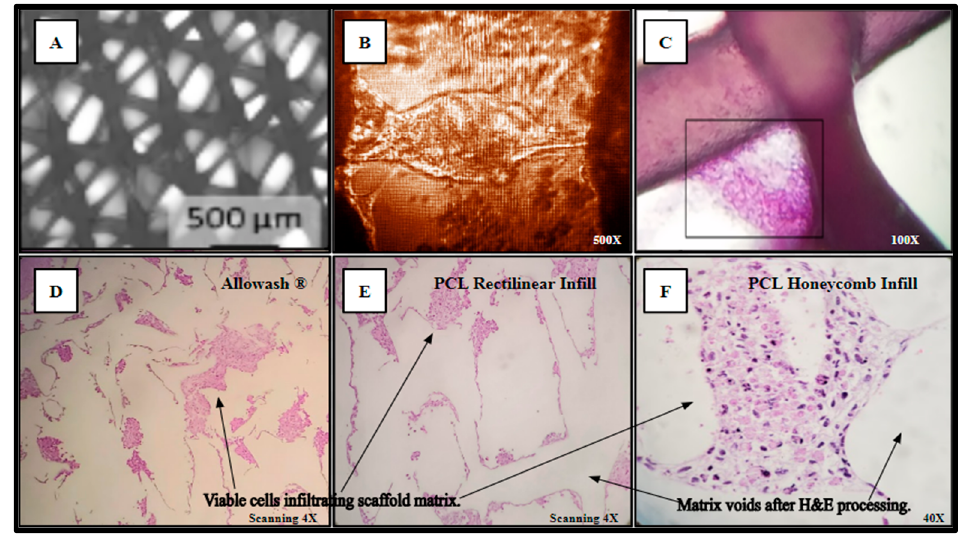
Figure 6. ( A – F ) Cell-scaffold infiltration and integration demonstrate a lack of detectable cytostatic or cytotoxic activity in culture with SAOS-2 representative cell line. or cytotoxic activity in culture with SAOS-2 representative cell line.